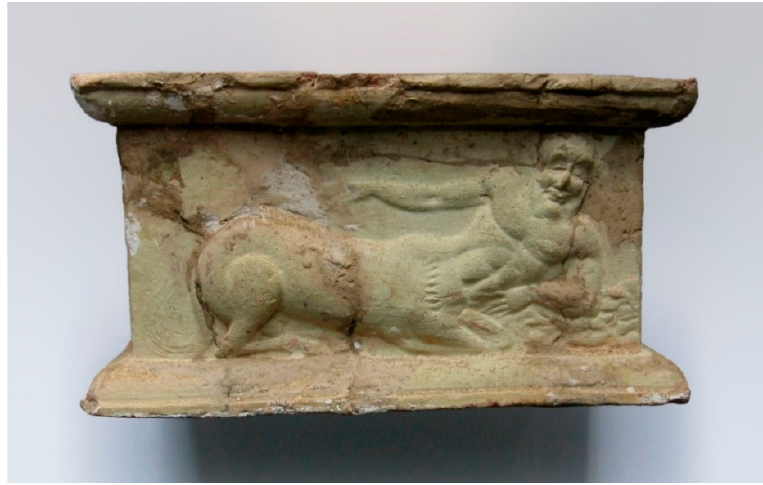
Figure 4. The reclining centaur Pholus (MGW inv. no. 500); terracotta altar ( arula ); ca. 5th century BCE .